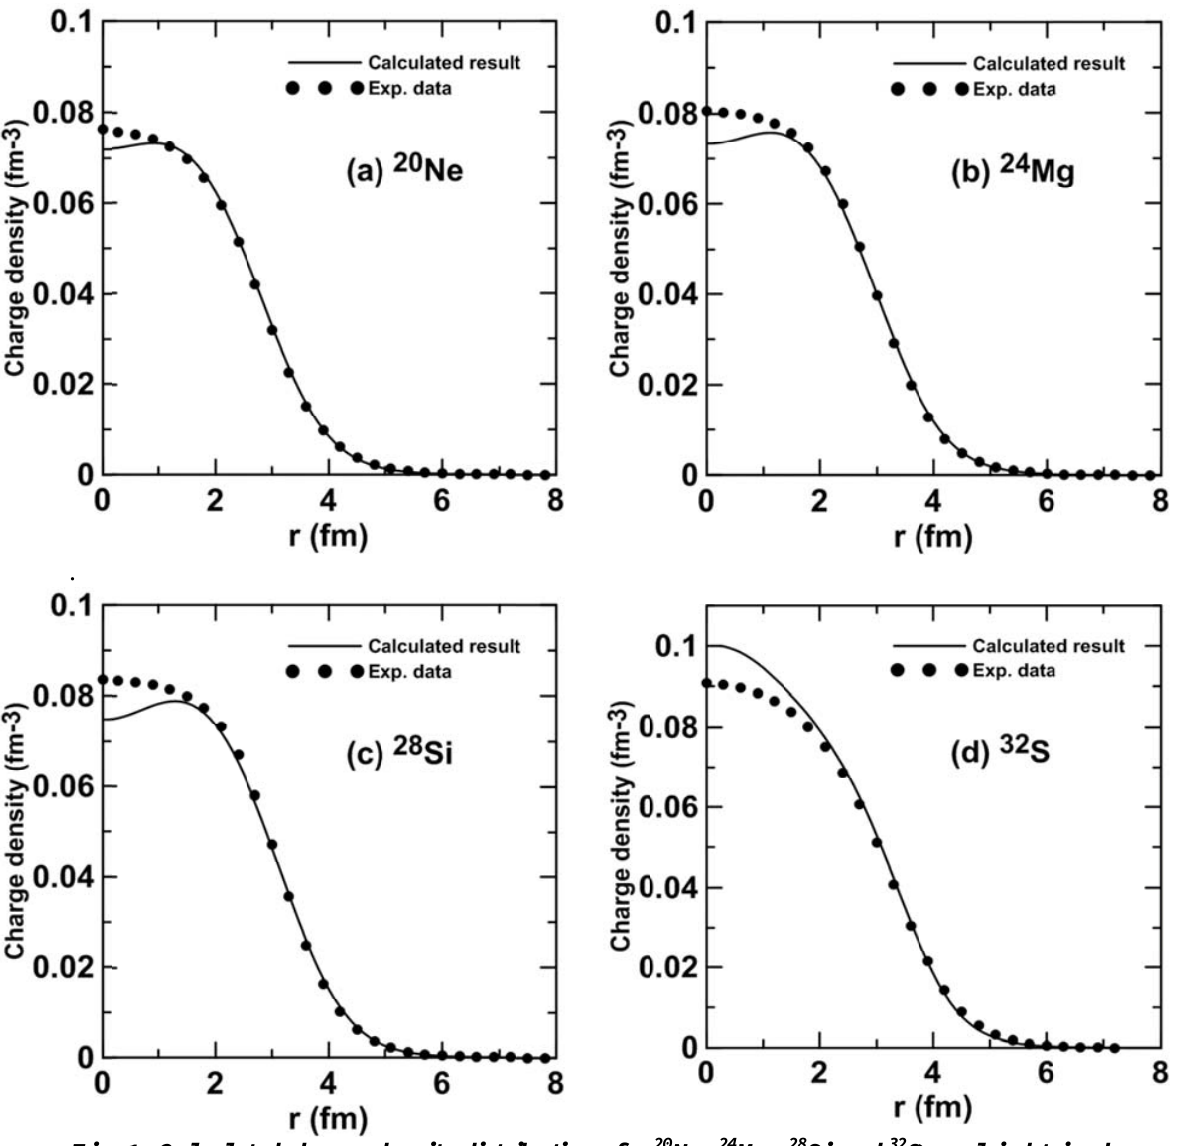
. 1: Calculat ted charge d density distri by S SKxs25 param meter compa ared with the T The charge and proton n densities f 20 Ne, 24 M the Mg, 28 Si an nd 32 S nucl usin ng the SKxs s25 are sho wn in Figs. (a) and (b), res spectively. The obtain valu ues of the charge den nsity for th 20 Ne e, 24 Mg and d 28 Si nuclei i at the cent ( r = = 0) have a approximat from m (0.072 fm m − 3 ) for 20 N Ne to (0.07 − 3 ) for 28 Si fm − with incre easing proto num mber. On th den sities for th hav e remained at a about 0.069 Fig. . 2 (b). T The charge